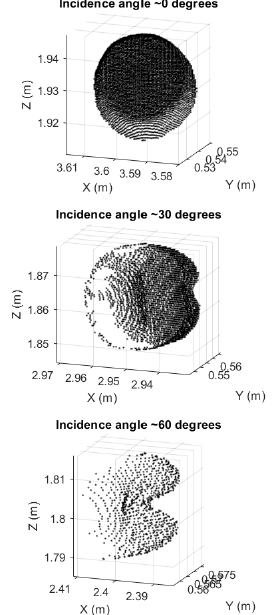
Figure 10: Hole signatures at various scan incidence